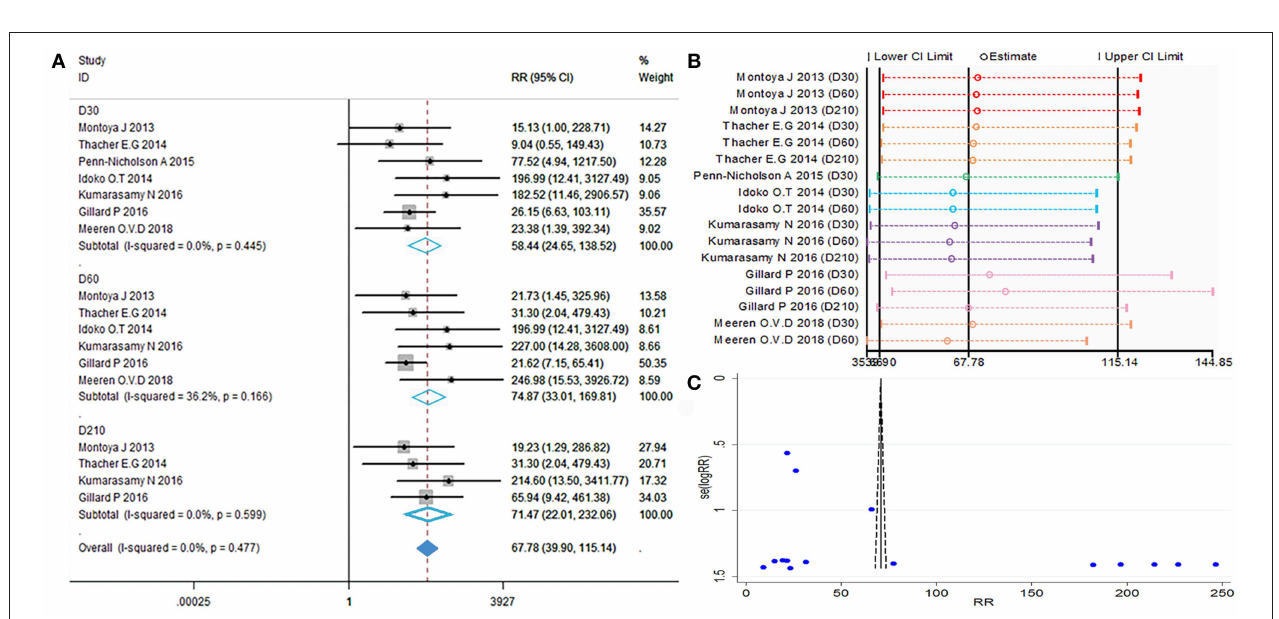
FIGURE 3 | Polyfunctional M72-specific CD8 + T-cell evaluation. (A) Forest plot: a SMD > 0 indicates that vaccine can effectively stimulate the growth of polyfunctional CD8 + T-cells. SMD = 0, invalid result. Point estimates and 95%CI are shown for each study and for the pooled results. (B) Influence analysis, examine the impact of a study on the total combined effect. The vertical solid line in the middle indicates the total combined effect, while the left and right vertical solid lines indicate 95%CI. (C) Funnel plot: the publication bias was independently assessed by determining the symmetrical distribution of the studies.